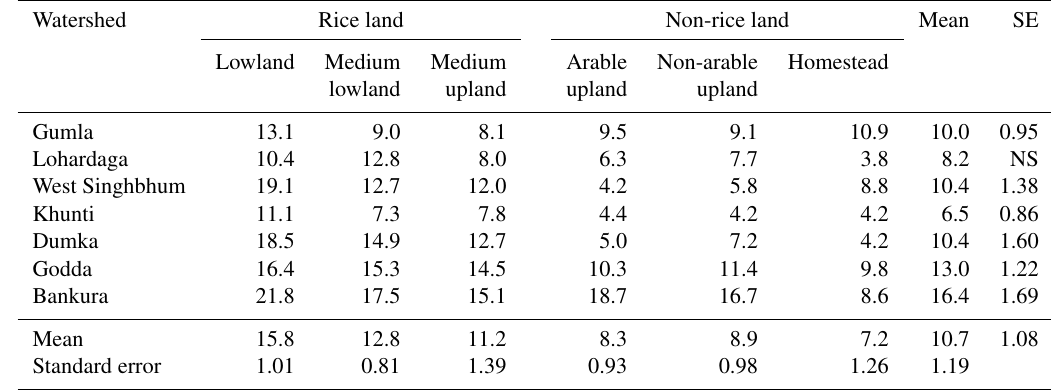
Table 4. Available soil P (Bray P;mgkg − 1 ) in seven EIP watersheds. Watershed Rice land Non-rice land Mean Lowland Medium Medium Arable Non-arable Homestead lowland upland upland upland Gumla Lohardaga West